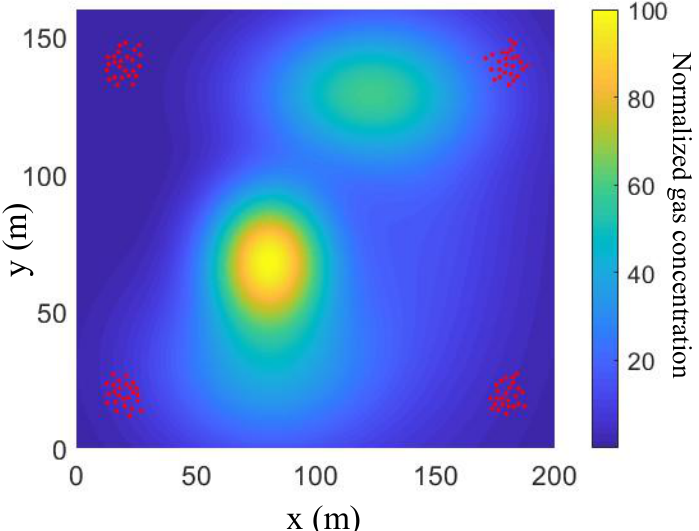
Figure 1. Gas concentration distribution in an indoor environment and initial robot deployment in ROI (plotted by red